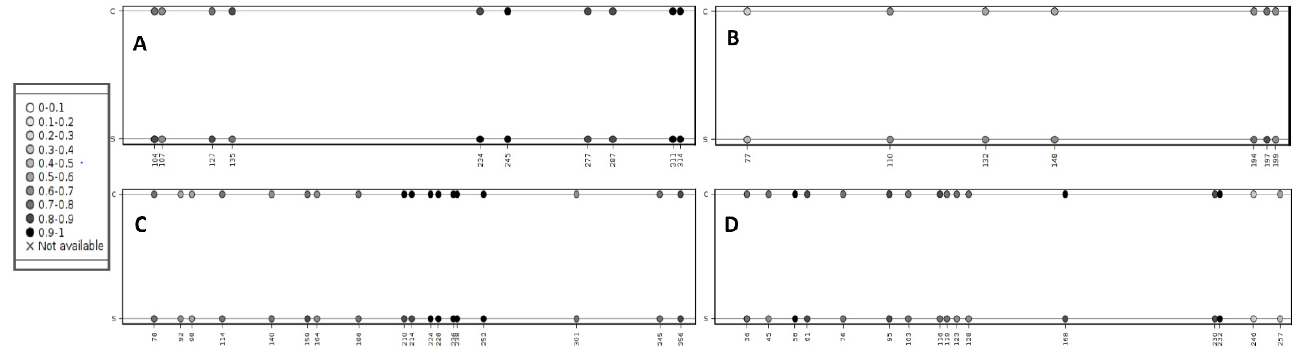
Figure 2. The lollipop-like plot depicting methylation levels of single CpG positions. Figure ( A ) stands for mir-101-1 results; ( B )—mir-10b results; ( C )—mir-200a results; ( D )—mir-338 results. Methylation levels for the control samples are in the upper part of each figure (indicated by letter “C”), while the methylation levels of the sarcoid samples are in the lower part of each figure (indicated by letter “S”). Methylation levels may range between 0 (no methylation, indicated by white circles) and 1 (100% methylation, indicated by black circles). Intermediate values are visualized with grayscale colored circles with 0.1 intervals (the legend). CpG positions are marked on the lower axis. The plot was created with the Methylation plotter web tool [36].